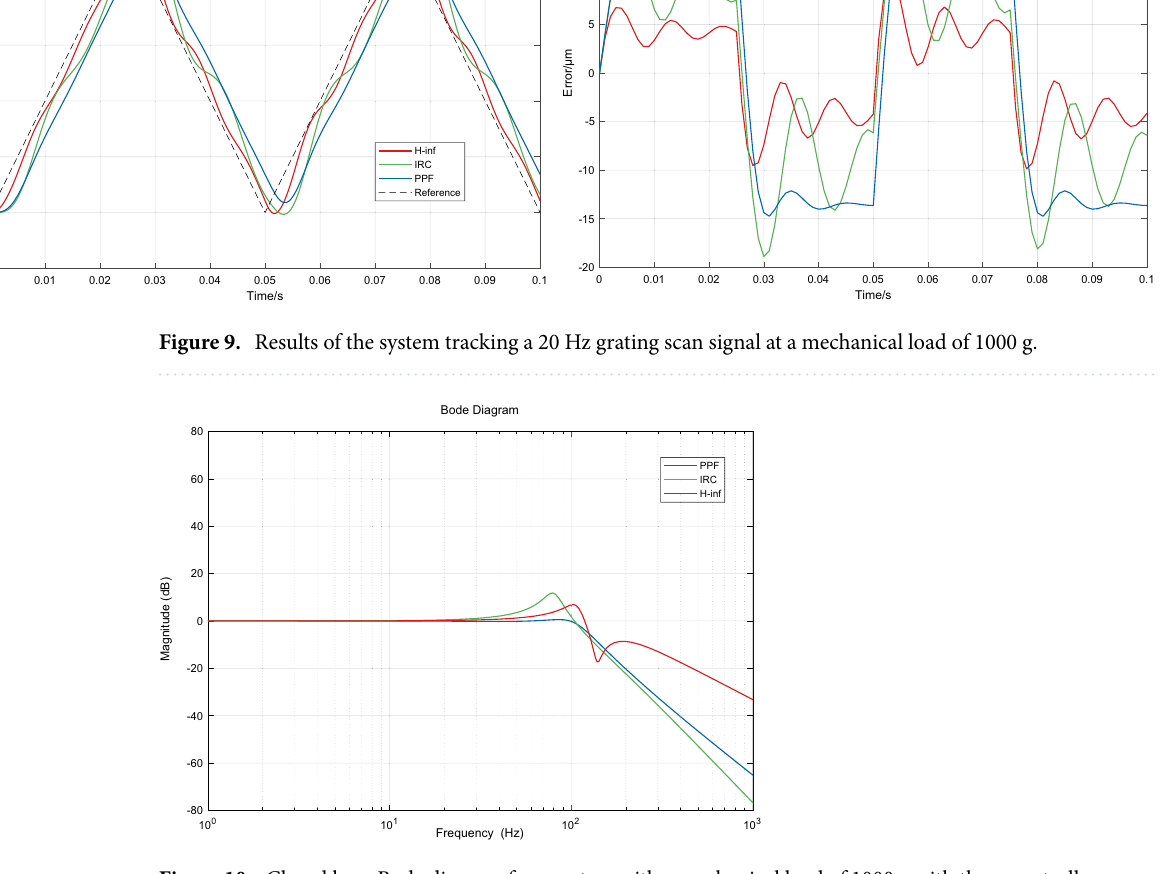
Figure 10. Closed loop Bode diagram for a system with a mechanical load of 1000 g with three